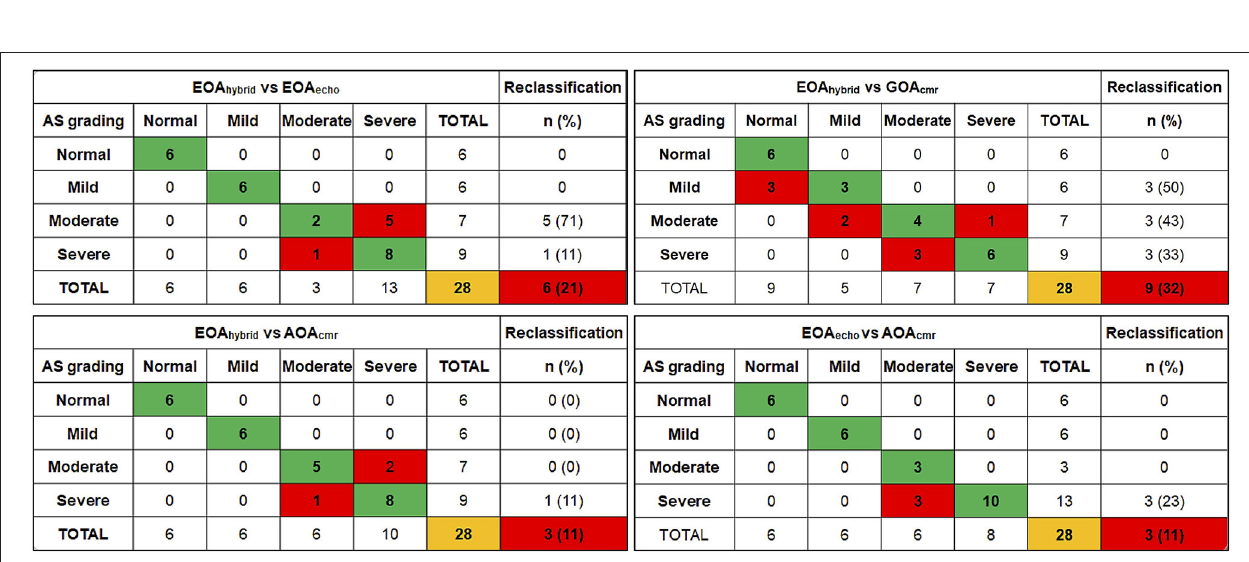
Frontiers in Cardiovascular Medicine | www.frontiersin.org